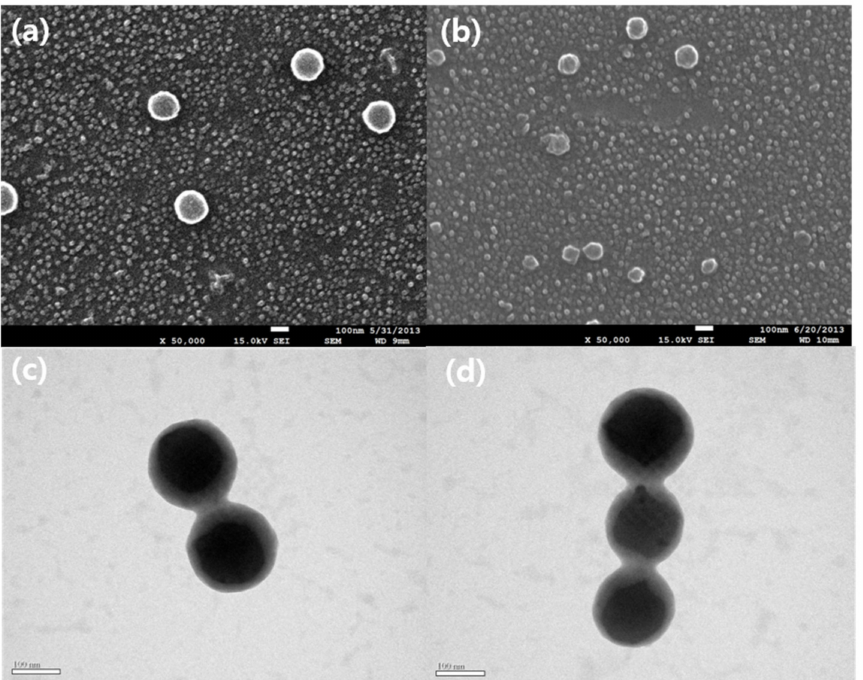
Figure 2. Morphological analysis of the PUA-NEPCMs prepared using different amounts of PSSMA. FE-SEM images of the materials prepared using ( a ) 2 g PSSMA, and ( b ) 4 g PSSMA. TEM images of the materials prepared using ( c ) 2 g PSSMA, and ( d ) 4 g